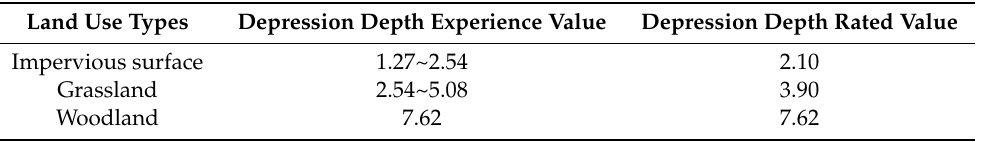
Table 2. Depression depth in di ff erent land use types.